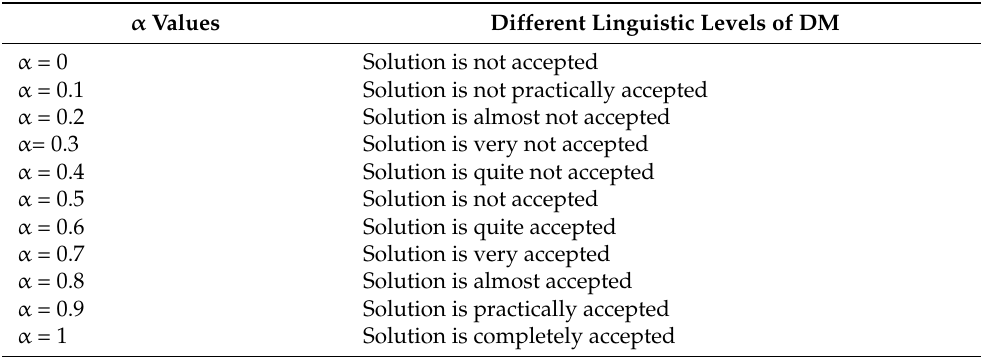
Table 1. Eleven scales of α with different linguistic levels of decision maker